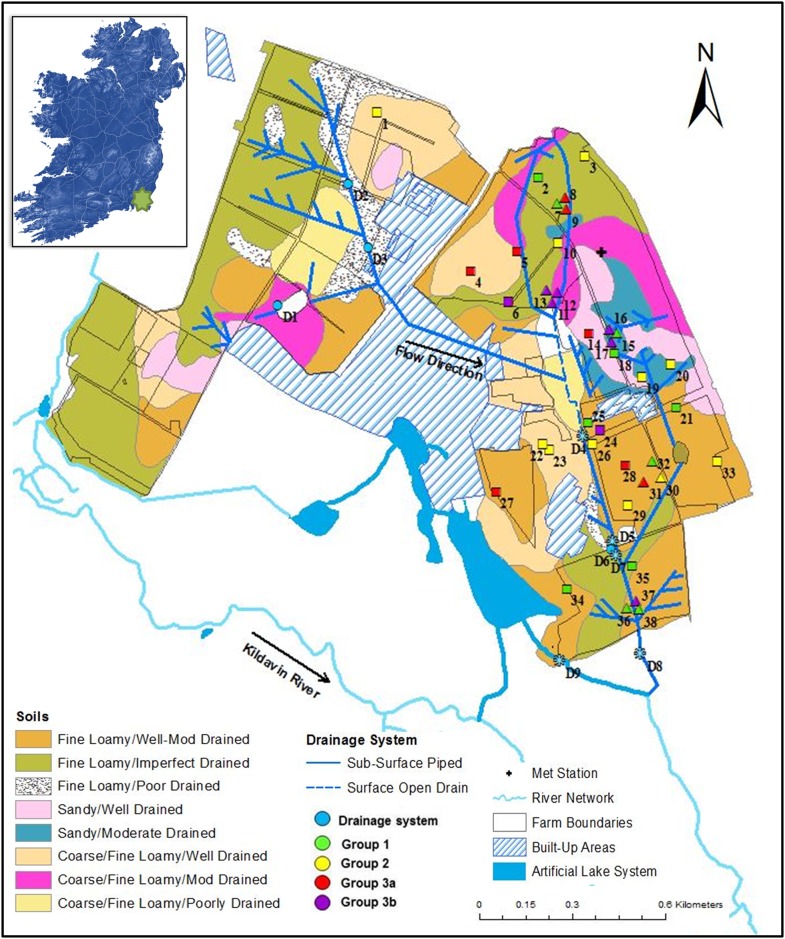
Map of the intensive farm merging soil texture, drainage class, position of the surface and subsurface drainage networks including the lake system and outlet and groundwater monitoring locations (Squares indicate piezometers, multilevel boreholes are indicated by triangles, end-of-pipe locations by circles and open ditch locations by asterisks).